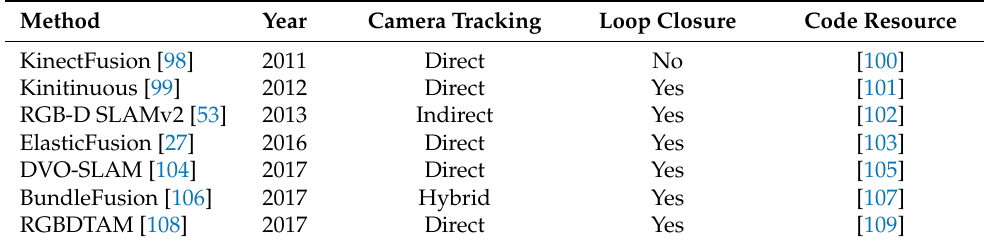
Table 6. Some SLAM algorithms for sensors with an RGB-D